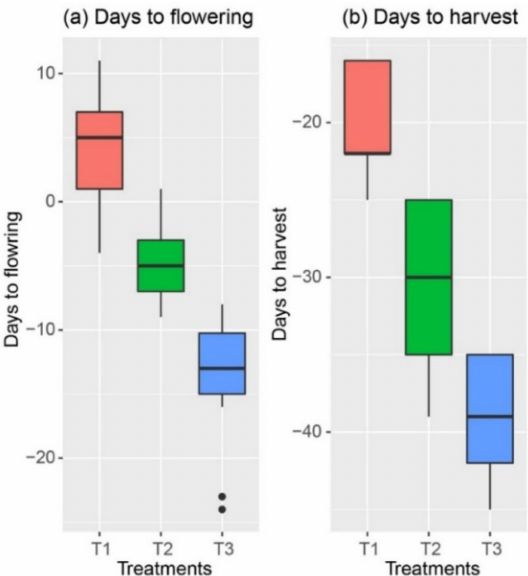
Figure 3. Days to flowering (DTF) and days to harvest (DTH) from the date of field hyperspectral (HS) measurements on 2 October 2017.